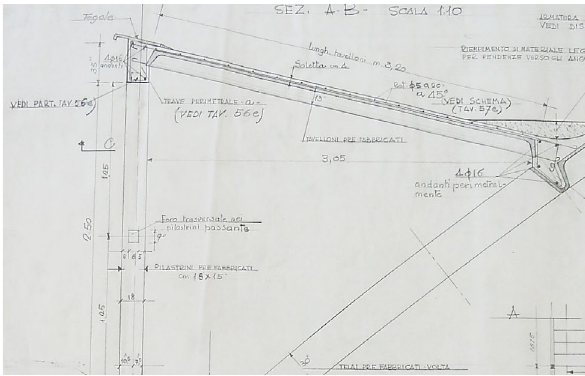
Figure 10 . Historical drawings for hall C: the constructive detail of the perimeter skylights, from CSAC Archive, Parma.